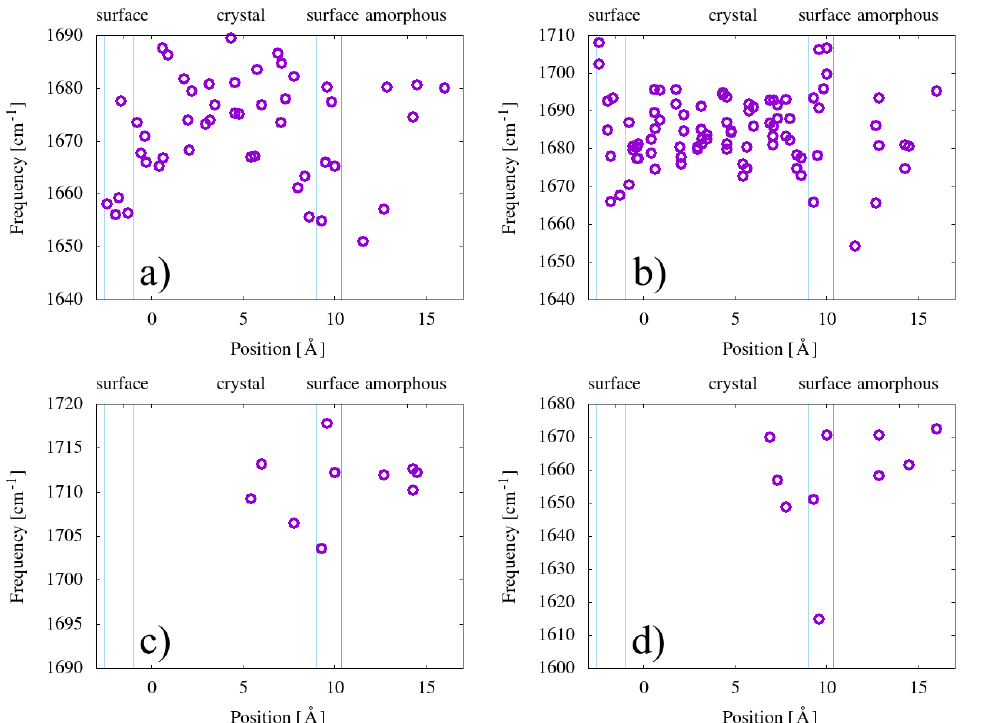
Figure 5. Calculated frequencies of the carbonyl group for ( a ) ketones, ( b ) esters, ( c ) carboxylic acids, and ( d ) enones, presented as a function of the position in the simulation cell in the direction perpendicular to the lamellae. Vertical blue lines delimit regions identified as amorphous, crystalline, and surface, as shown on top of the